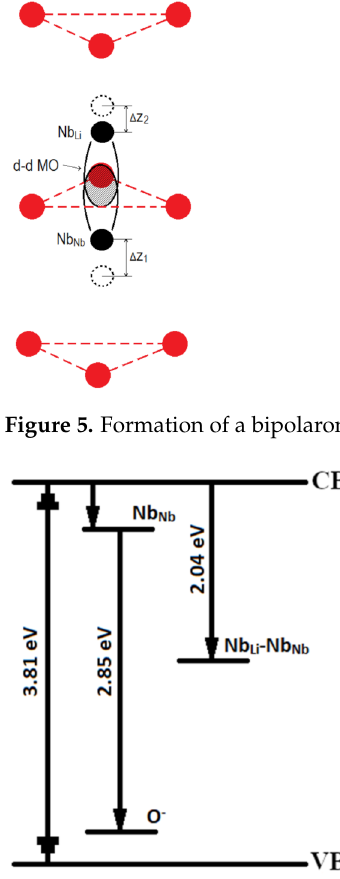
Figure 6. Qualitative scheme of the main channels of radiative recombination in the visible region of the spectrum according to the data of the fundamental absorption edge and PL of the CLN